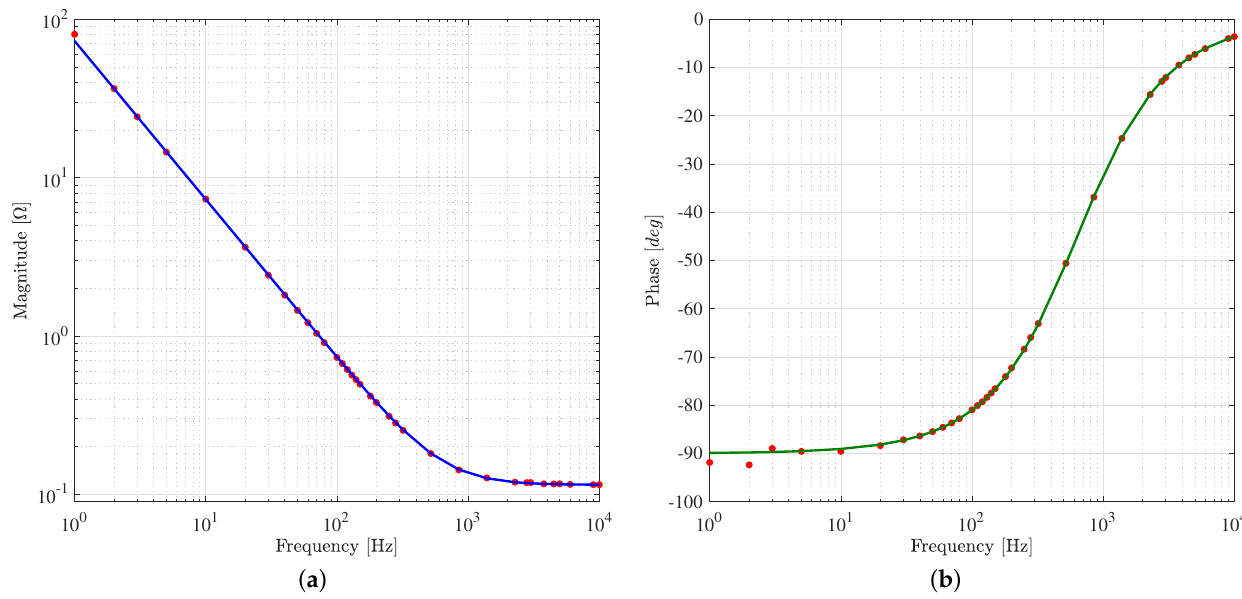
Figure 11. Multiple curve-fitting for magnitude and phase with MPPT ON at 400 W/m 2 . ( a ) Magnitude. ( b ) Phase.